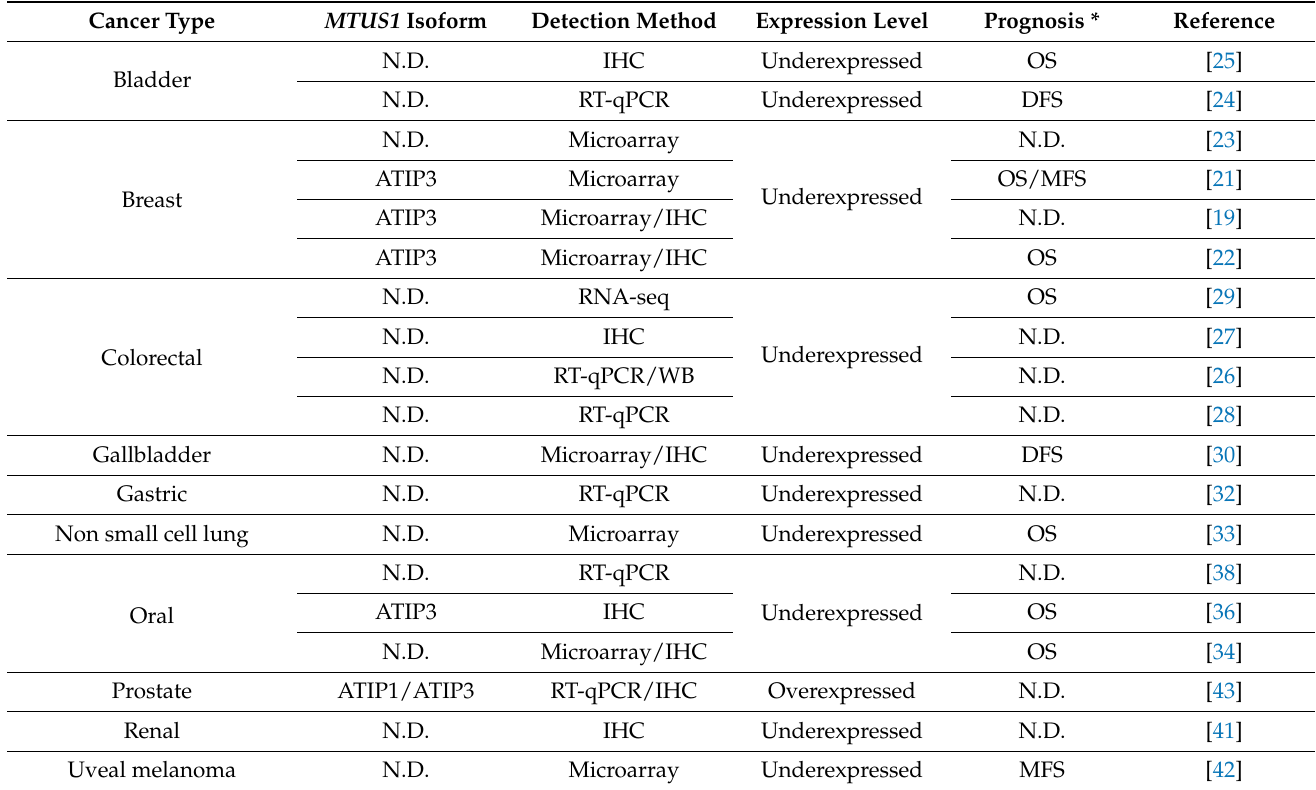
Table 1. MTUS1 gene status in human